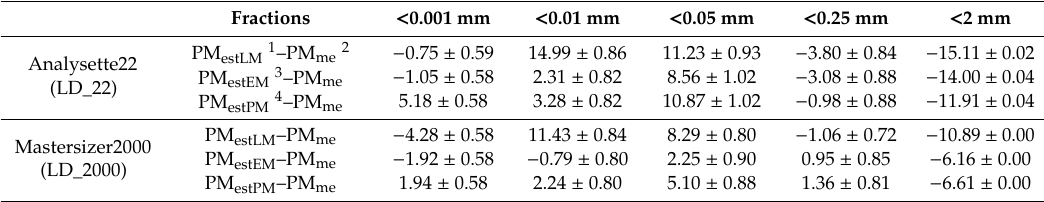
Table 3. Verification of the results. Di ff erences (%) between calculated estimated values using laser di ff raction and di ff erent regression models (PM estLM , PM estEM , and PM estPM ) and originally measured PM values (PM me ) present as mean values ± standard